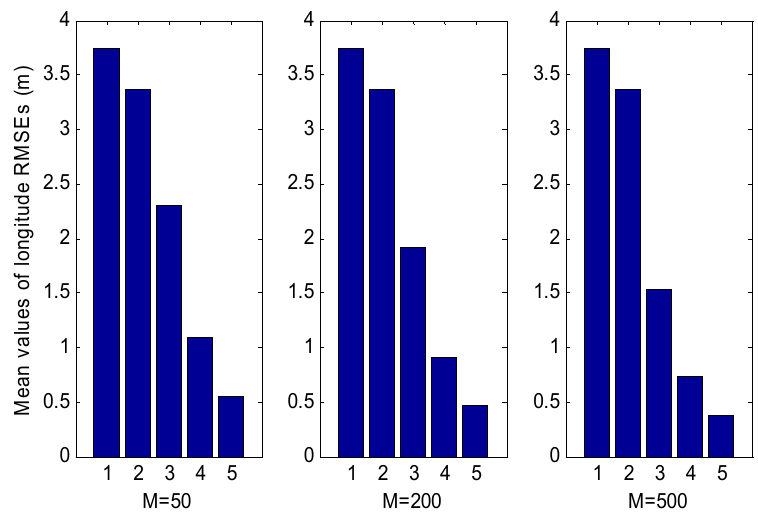
Figure 7. Mean values of the longitude RMSEs of EKF, UKF, PF, UPF and ASUPF, where the mean values for PF, UPF and ASUPF are subject to different particle numbers M = 50, M = 200 and M = 500 and the numbers from 1 to 5 indicate EKF, UKF, PF, UPF and ASUPF, respectively.